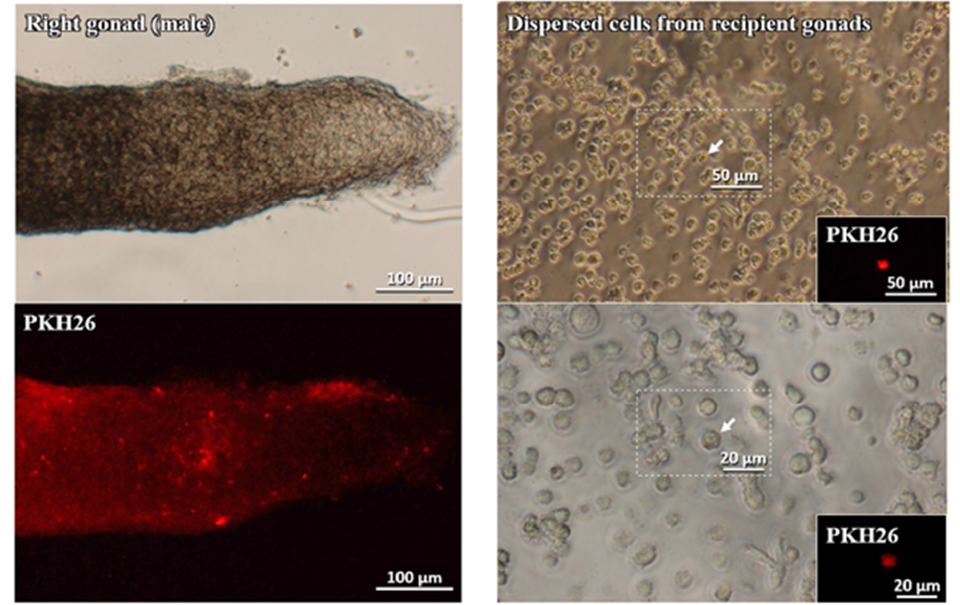
Figure 4. Left panel: Male gonad observed under the microscope (Leica DMI8) and stained with PKH26. Right panel: Dispersed cells from the recipient gonads and stained with PKH26.